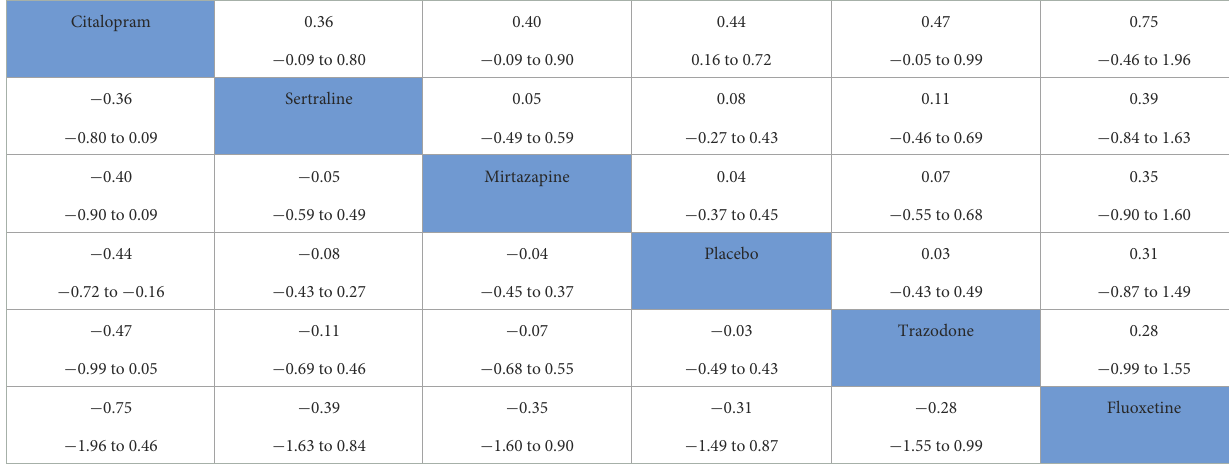
TABLE 2A League table for antidepressant drug efficacy.